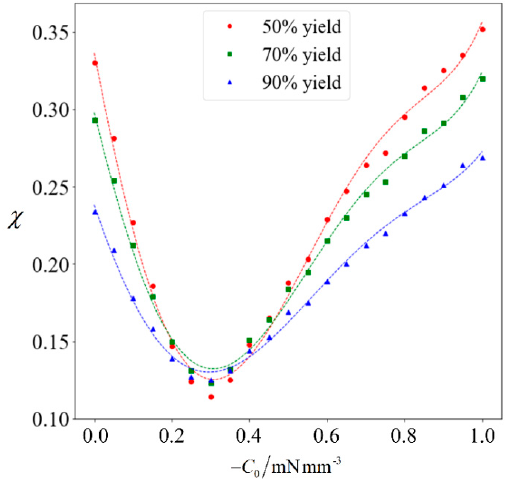
Figure 8. Purity as a function of C 0 . The red circles, green squares and blue triangles denote the computed purity corresponding to a yield of 50%, 70% and 90%, respectively. The dotted lines in matching color are the best-fit polynomials.